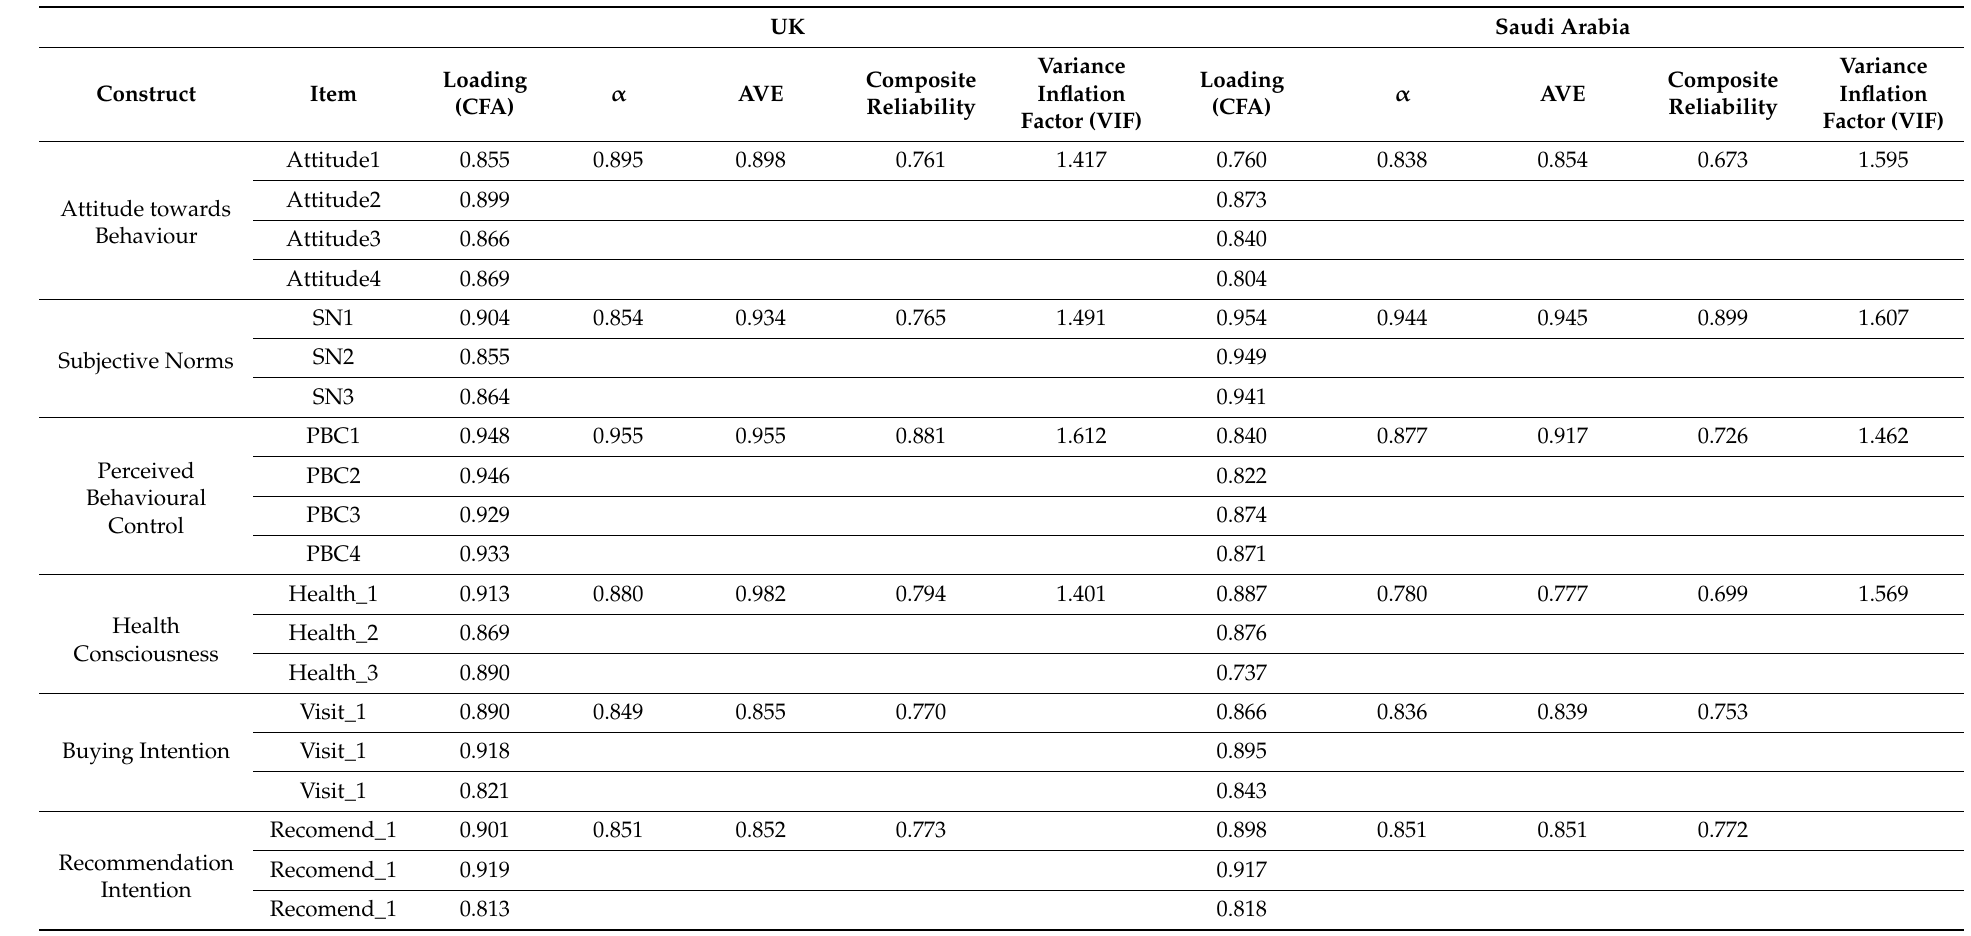
Table 1. The psychometric properties of the employed scale. UK Saudi